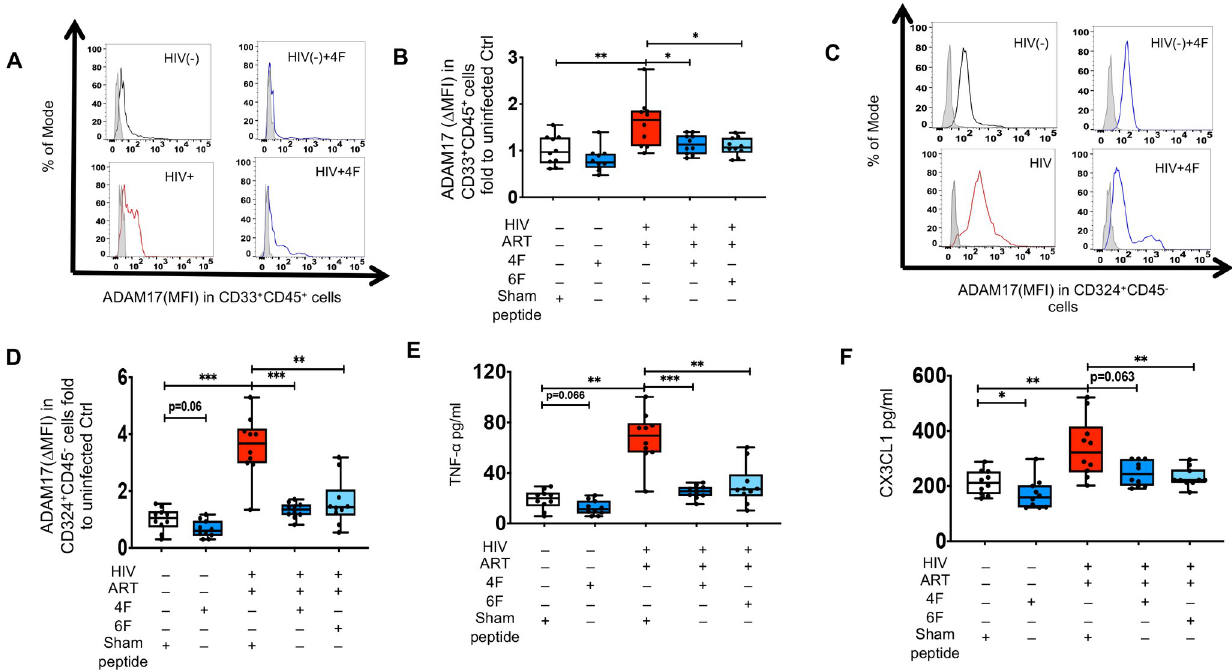
Fig 4. ApoA-I mimetic peptides attenuate ex vivo proteins levels of ADAM17 and associated cytokines and chemokines in gut explants of uninfected and HIV infected participants. Gut biopsies were obtained from uninfected (n = 10) and HIV infected participants on potent antiretroviral therapy (ART) (n = 10) and gut explants were treated with 4F or 6F apoA-I mimetic peptides or sham peptide for 72 hours as in Materials and Methods. Gut biopsies from the same participants were used for experiments with treatments. A-D. Protein levels of A disintegrin and metalloprotease 17 (ADAM17) was detected in myeloid CD33 + CD45 + (A, B ) and CD324 + CD45 - epithelial cells (C, D ) isolated from gut biopsies obtained from uninfected and HIV infected participants treated as shown. A, C . Representative data of flow cytometry data of protein levels (Median fluorescence intensity) of ADAM17 are shown for myeloid CD33 + CD45 + (A ) and CD324 + CD45 - epithelial cells (C ). Δ MFI represents a shift in median fluorescence intensity of a positive cell population compared to a negative cell population within each sample. The negative cell population was defined based on a fluorescence minus one negative control for staining as shown in light filled grey histogram. B, D. Summary data for protein levels of ADAM17 in intestinal myeloid CD33 + CD45 + ( B ) and CD324 + CD45 - epithelial cells ( D ) from gut biopsies treated as shown. E, F. Supernatants were collected at 72 hours and Luminex immunoassays were used to determine protein levels of cytokines [tumor necrosis factor alpha (TNF- α )]( E) and chemokines [C-X3-C Motif Chemokine Ligand 1 (CX3CL1)] ( F) , that are mediated by ADAM17 sheddase activity. Data represent box and whiskers with minimum, median and maximum values. Datapoints represent mean of 3 gut biopsies per participant. The Mann-Whitney test was used to compare 2 groups ( � p < 0.05, �� p < 0.01, ��� p < 0.001).